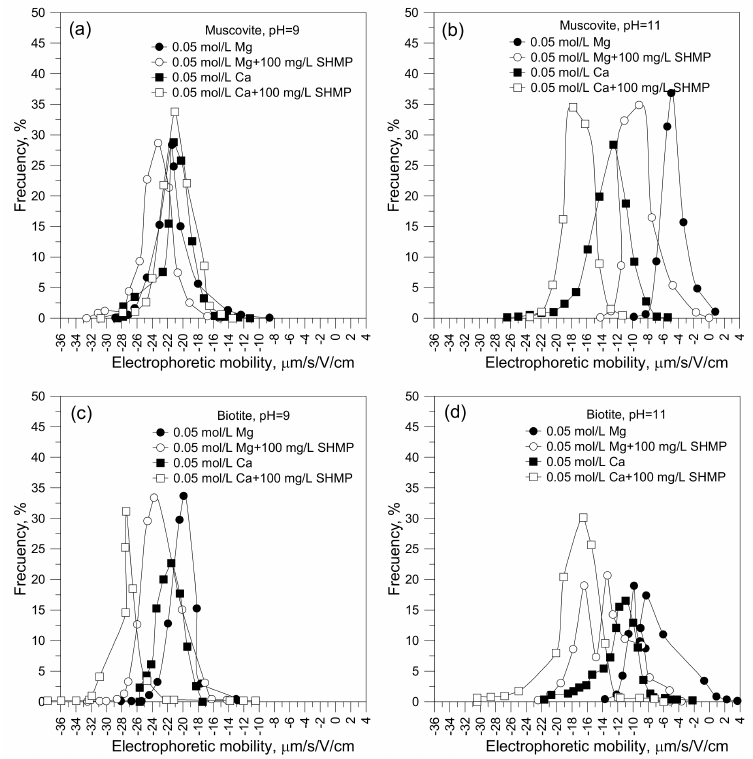
Figure 6. Electrophoretic mobility distributions of particles of muscovite ( a , b ) and biotite ( c , d ), with and without SHMP, in aqueous solutions of magnesium and calcium, and at pH 9 and 11.